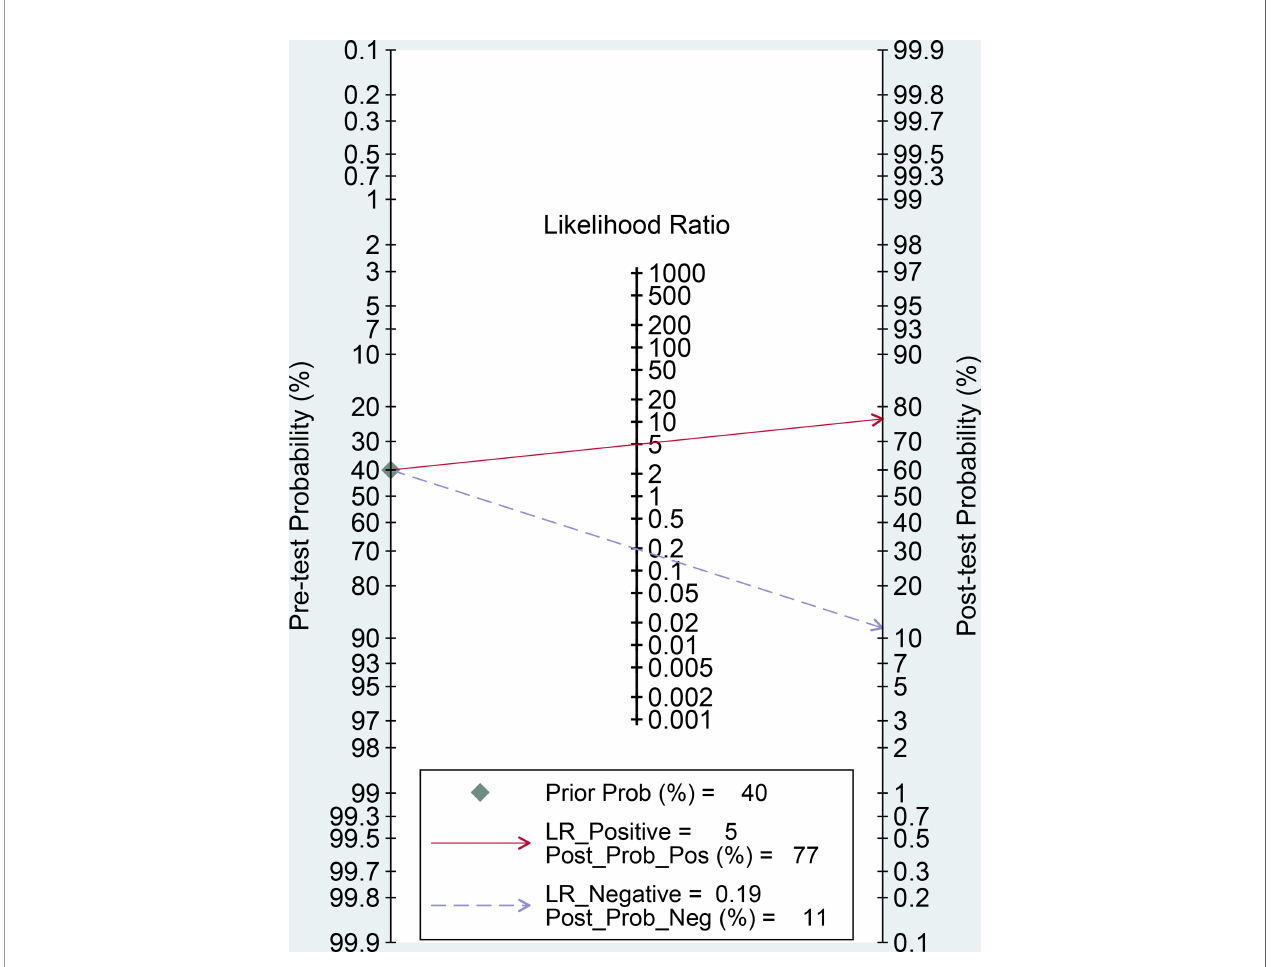
FIGURE 6 | Fagan nomogram of radiomics for the preoperative identi fi cation of microvascular invasion in hepatocellular carcinoma. LR, likelihood ratio; Prob, probability; Pos, positive; Neg, negative.